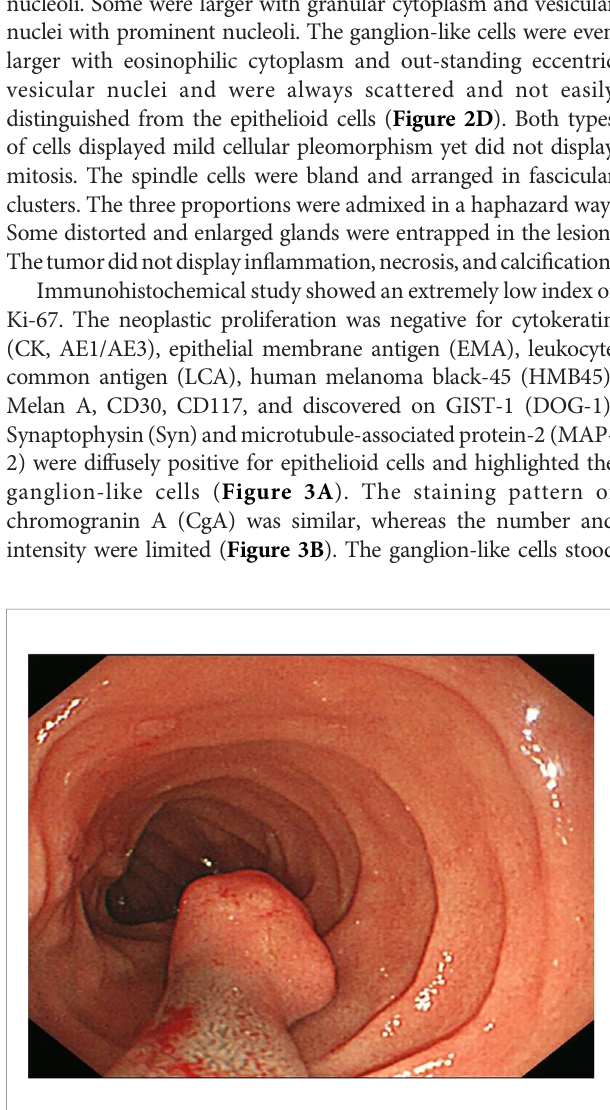
FIGURE 1 | A sessile polyp human melanoma black-45 (HMB45) measured about 1 cm in diameter with a smooth surface was found in gastrointestinal